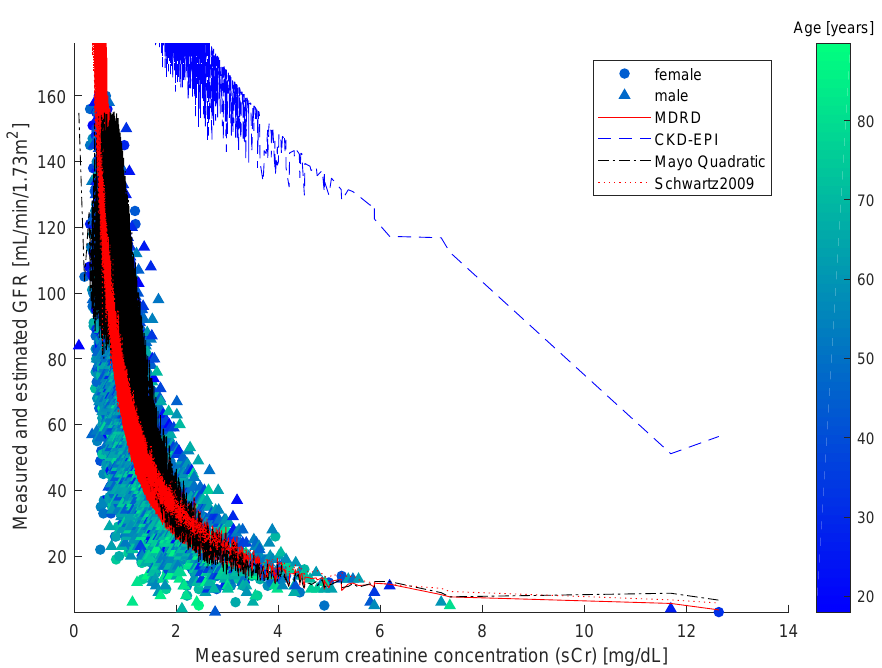
Figure 5. Comparison of predictions made using different equations (MDRD, CKD-EPI, Mayo Quadratic and updated Schwartz) on an adults dataset.